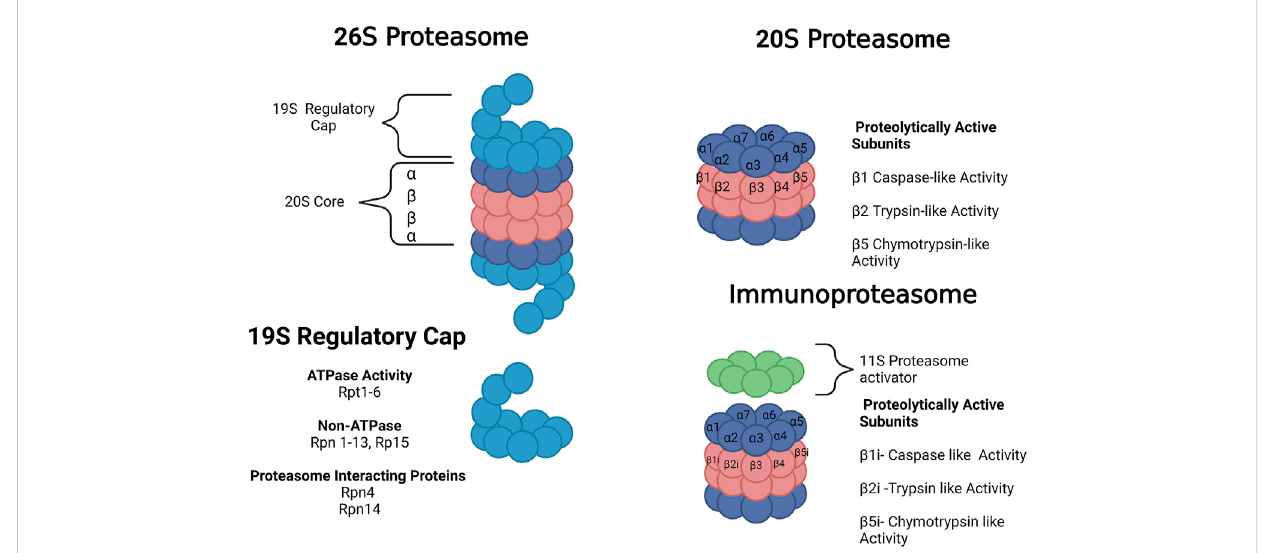
FIGURE 2 Forms oftheproteasome.The 20S proteasome represents free20S. The 26 S proteasome is composed of the20S core with a19Sregulatorycap at thetoporbottomofthecore.Theimmunoproteasomecontainsa20Scorewith3alternativesubunits( β 1i, β 2iand β 5i)andan11Sregulatorycap.The20S proteasomecoreiscomposedof28subunitsdividedinto4heptamericringsinan α ring, β ring, β ring, α ringconformationcomposedofsubunits α 1-7or β 1-7, respectively. There are 3 proteolytically active subunits in the core – β 1, β 2, and β 5 – associated with caspase-like, trypsin-like, and chymotrypsin-like activities, respectively. The 19S regulator is composed of a range of subunits with ATPase, non-ATPase, and proteasome-interacting functions. Images Created with